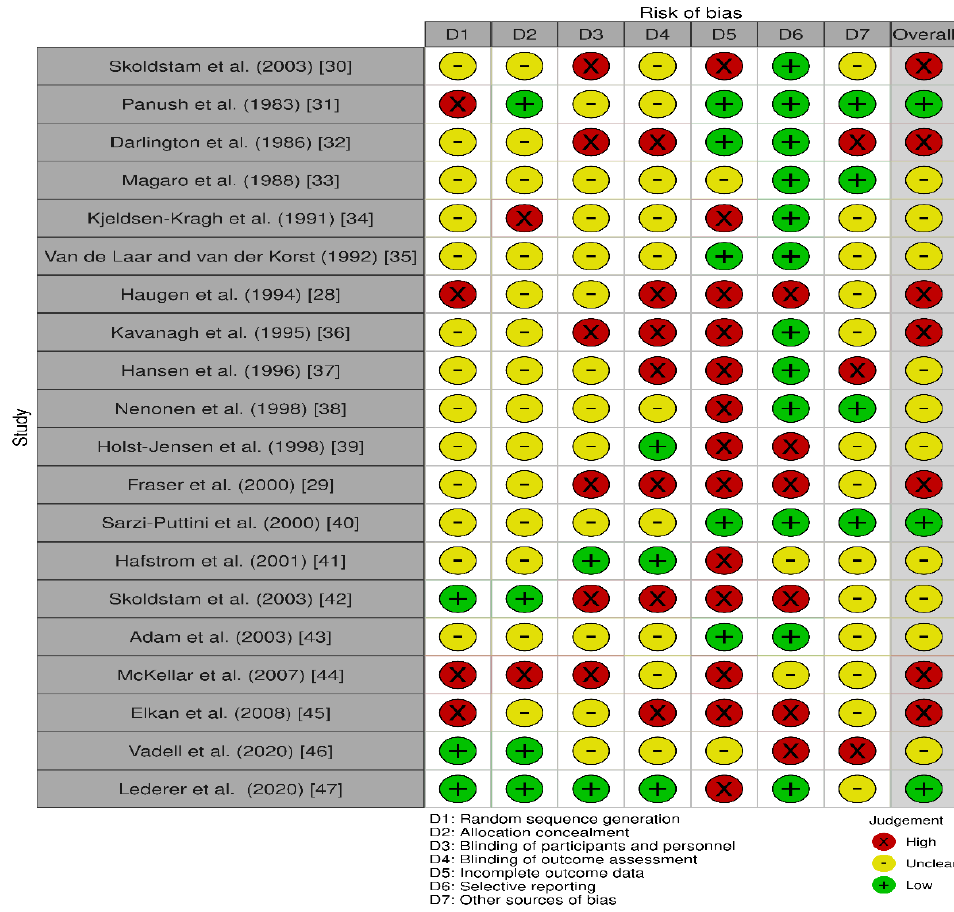
Figure 2. Risk of bias summary: review authors’ judgments about each risk of bias item for each included